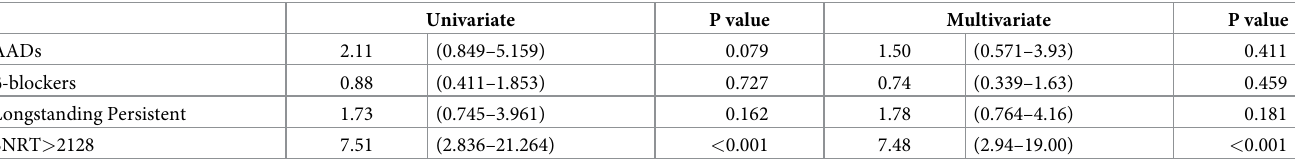
Table 2. Predictors of clinical